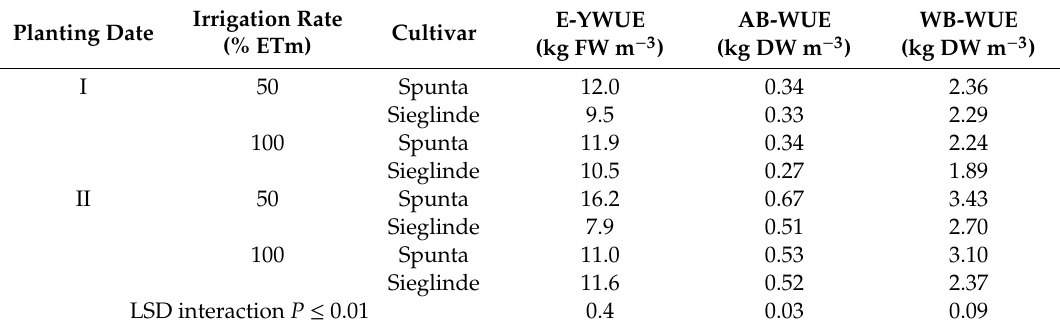
and for Whole Biomass (WB-WUE) as a ff ected by interaction ‘planting date × irrigation rate × cultivar’. Planting